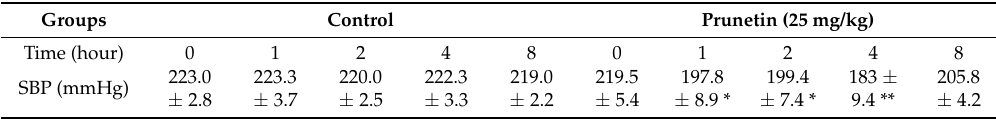
Table 1. Effects of prunetin on systolic blood pressure (SBP) in spontaneously hypertensive rats (SHR). Groups